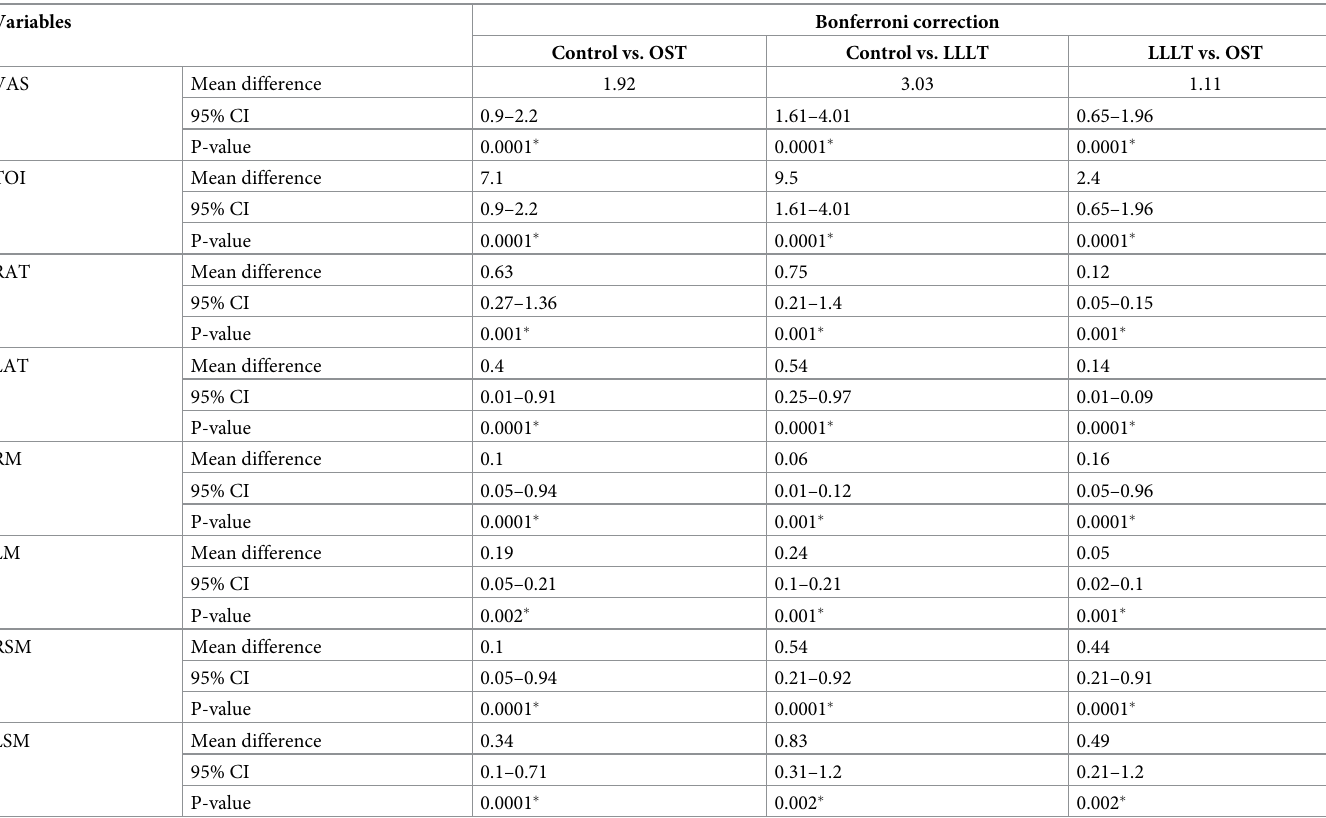
Table 3. Post-hoc pairwise comparisons between